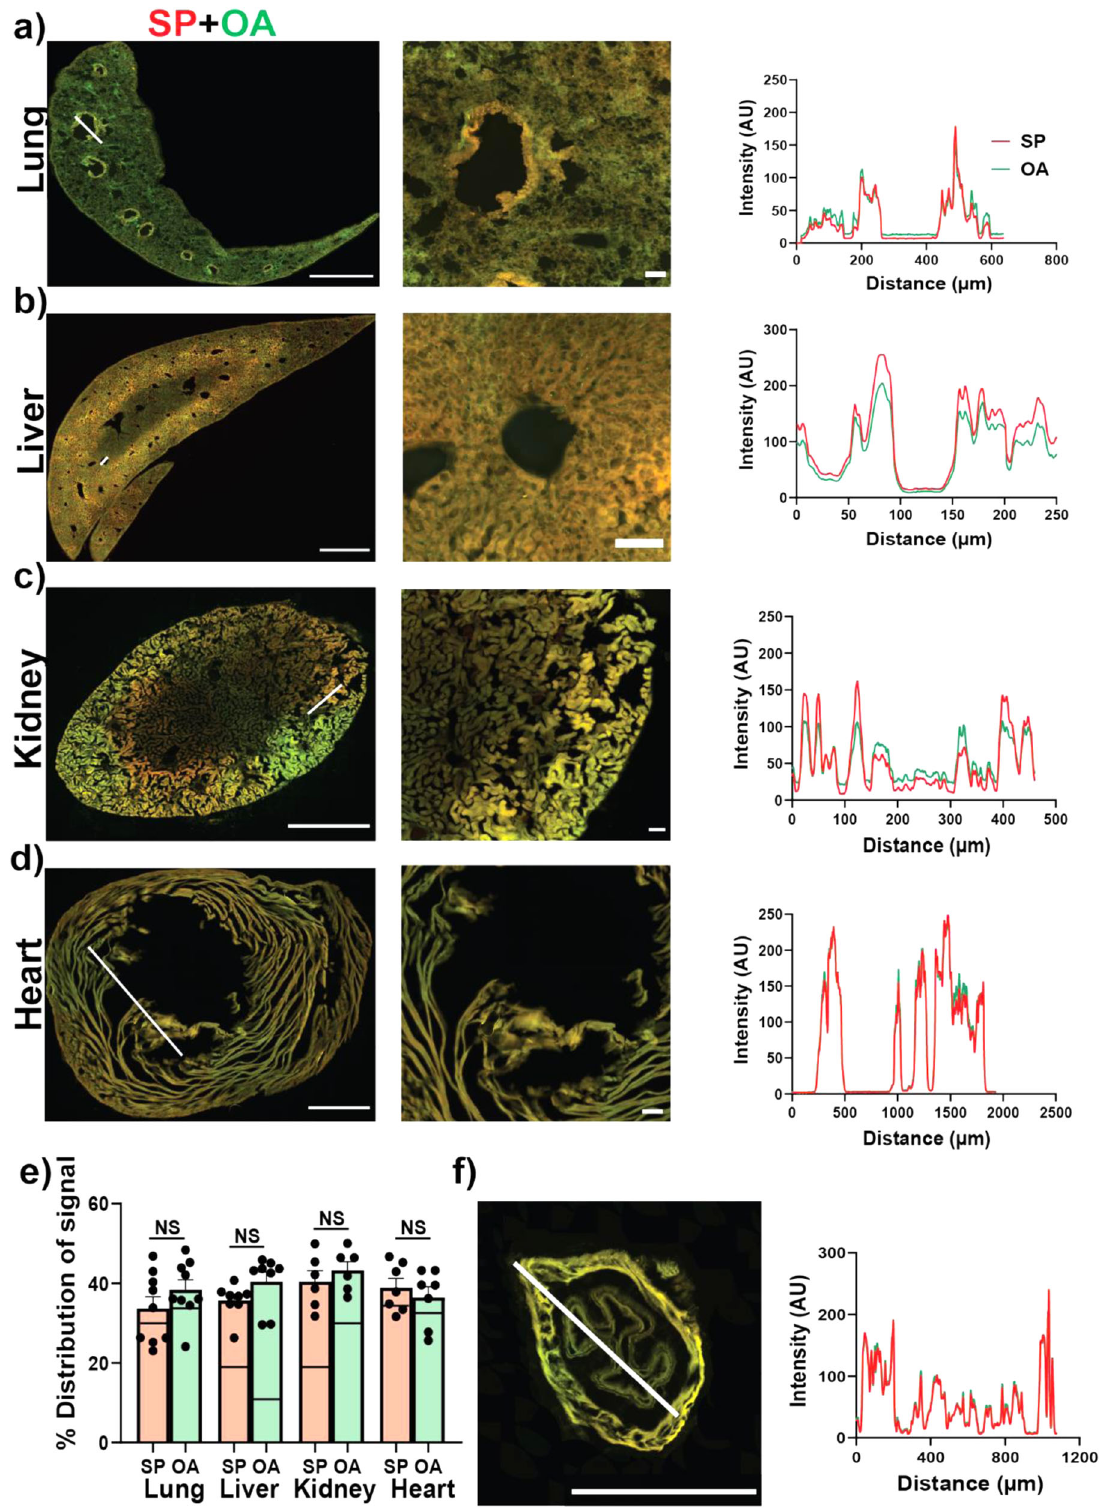
Fig. 4 SP-555 peripheral tissues biodistribution. a – d Representative merged images of SP-555 and OA-488 with magni fi ed images and intensity plots at the respective white lines. e Quanti fi cation of SP-555 and OA-488 distribution area for the whole section with the auto fl uorescence levels (lines) from the non-injected mice. f Merged image of a primary bronchus with intensity plot. Scale bars: a – d and e (1 mm). Values are mean ± SEM, N = 3 – 4 mice. Images not